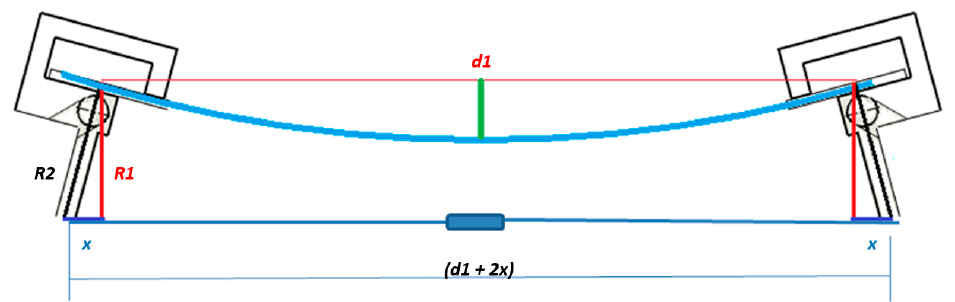
Figure 15. Illustrative image of the operation of the bending system. The horizontal red line shows the mirror’s rest position; once the torque is applied, the mirror curves following the blue line.